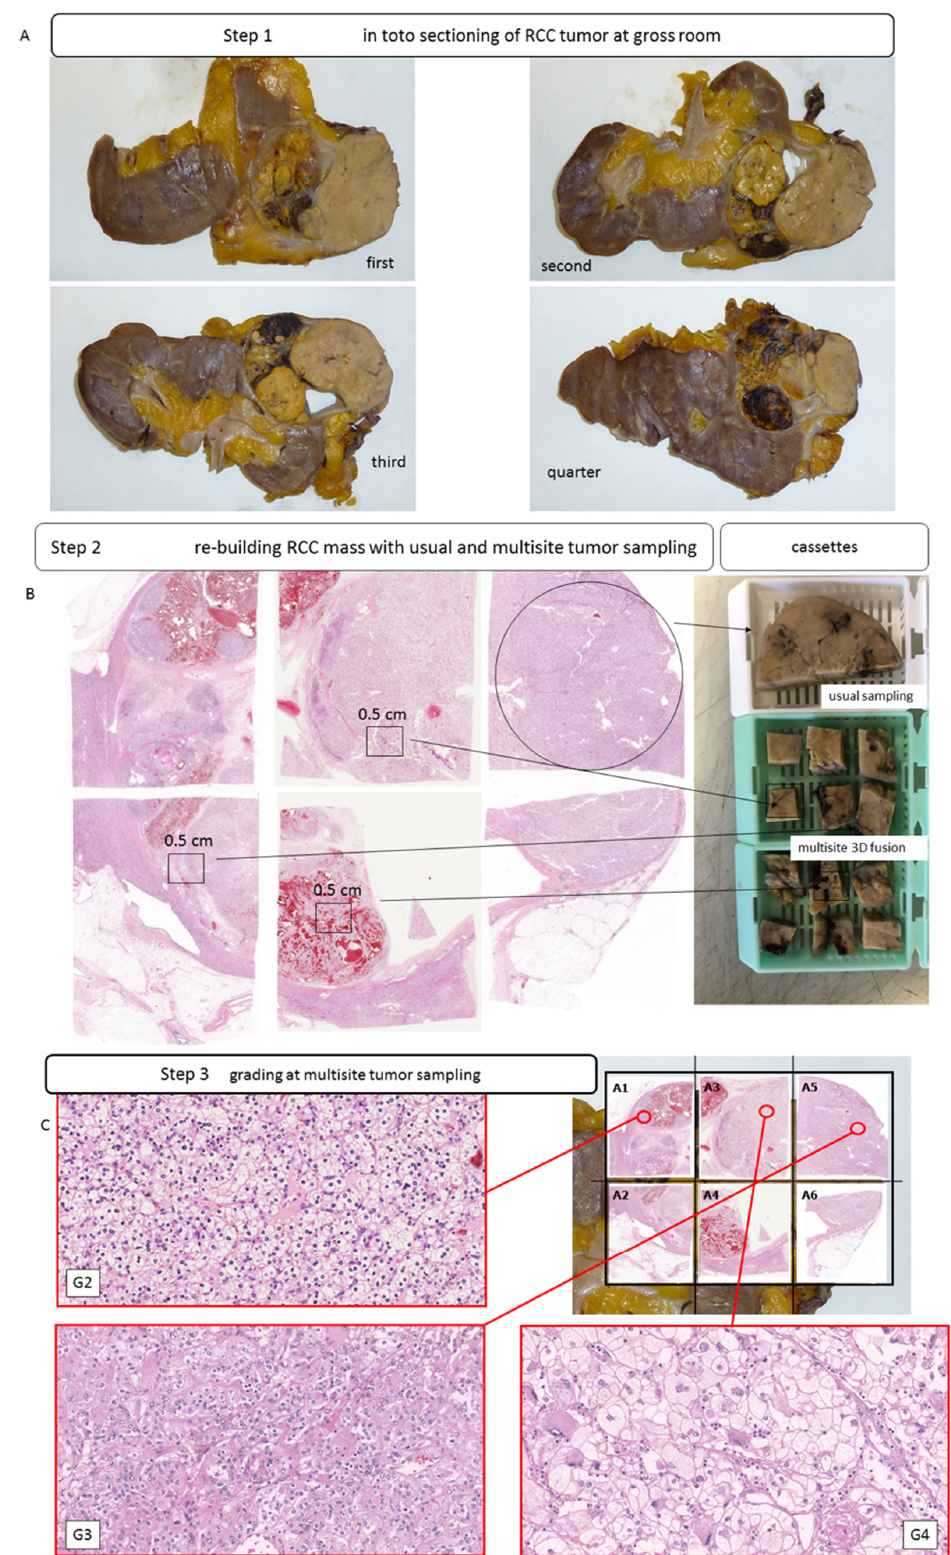
Figure 1. Intratumoral heterogeneity in clear cell RCCs. Gross images of different slices of clear cell RCCs with heterogenous macroscopic appearance ( A ); usual block (white cassette) and multisite sampling with 6 pieces of tumor tissue per single block (green cassette) and 3D fusion multisite reconstruction ( B , C ); H&E staining ( C